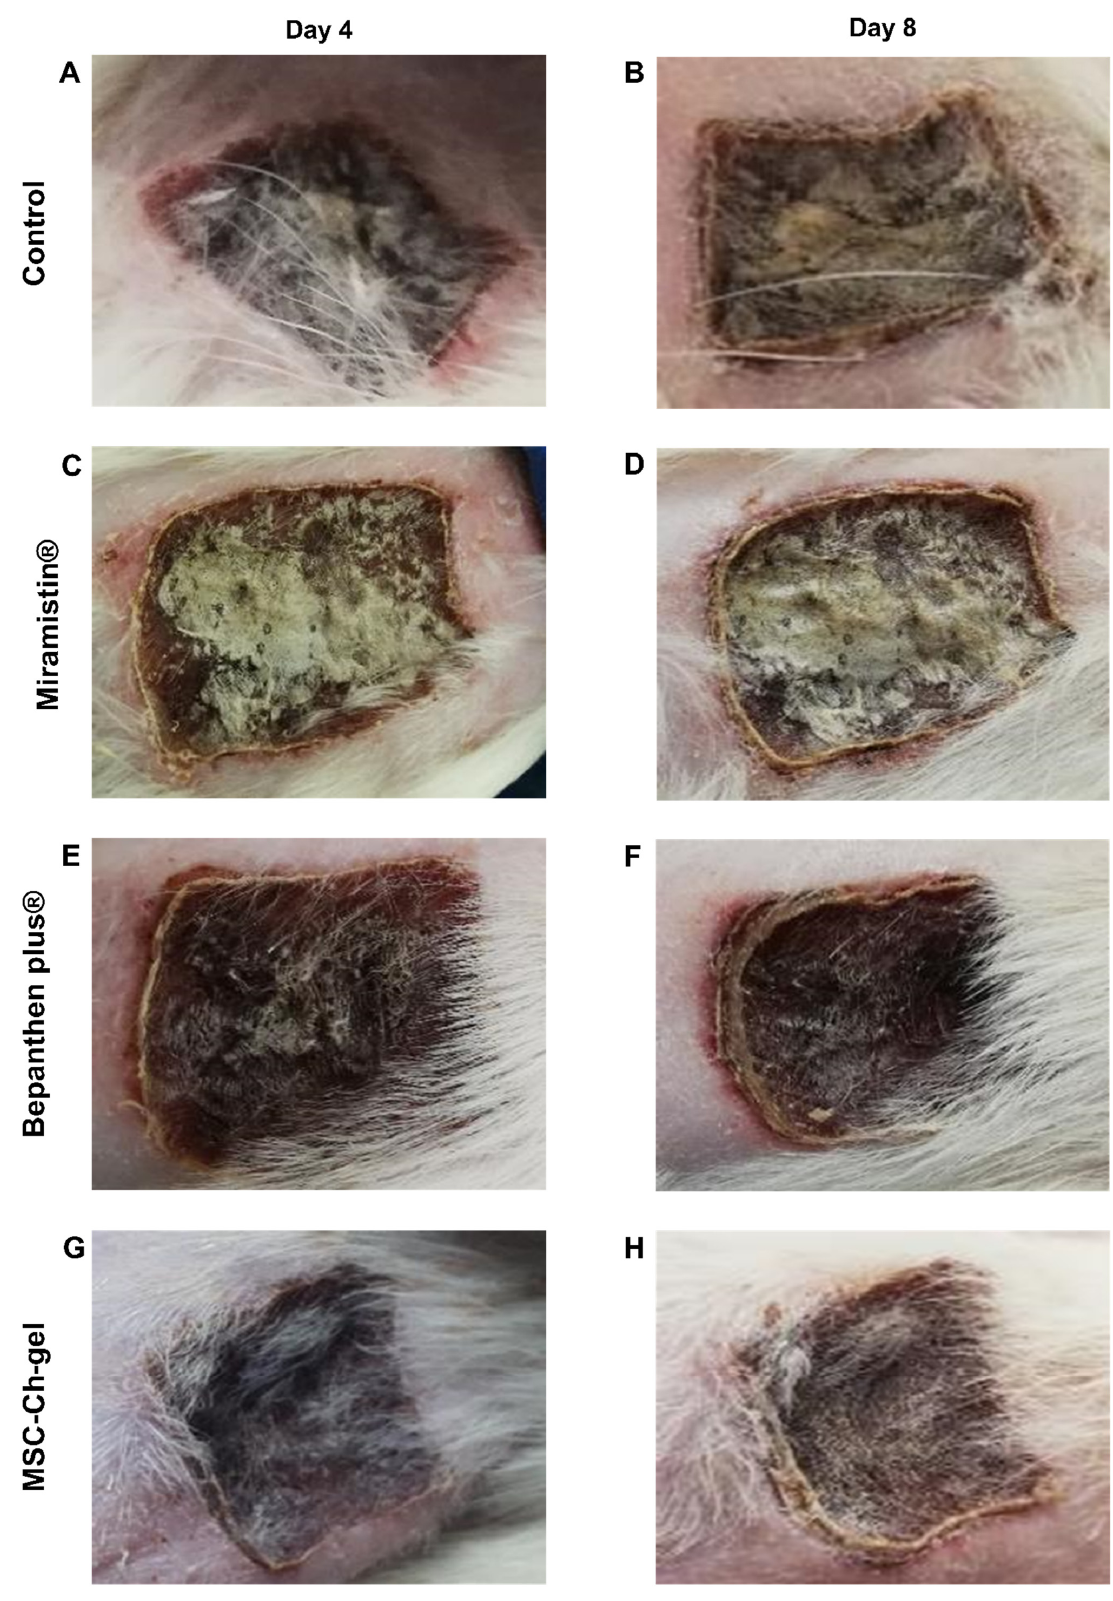
Figure 5. Representative visual appearance of the wound for different treatment groups on day 4 and 8. ( A , B ) Control. ( C , D ) Miramistin. ( E , F ) Bepanthen Plus. ( G , H ) MSC-Ch-gel. MSC-Ch-gel, multipotent mesenchymal stromal cell secretome- based chitosan